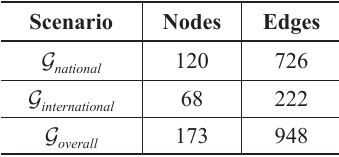
Number of nodes and edges for each connection